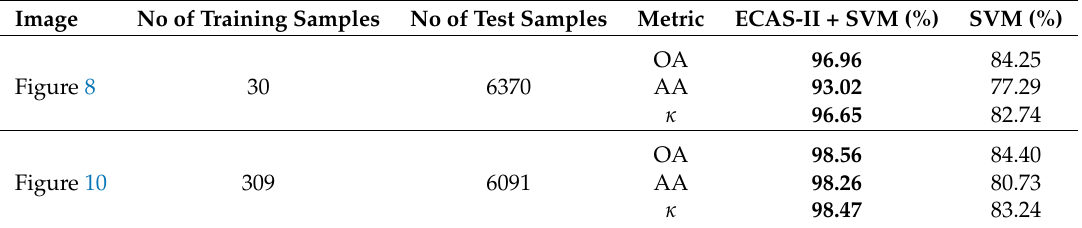
Table 2. Classification accuracies (%) for the raw pixel-wise SVM and the ECAS-II + SVM algorithm applied to the synthetic images shown in Figures 8 and